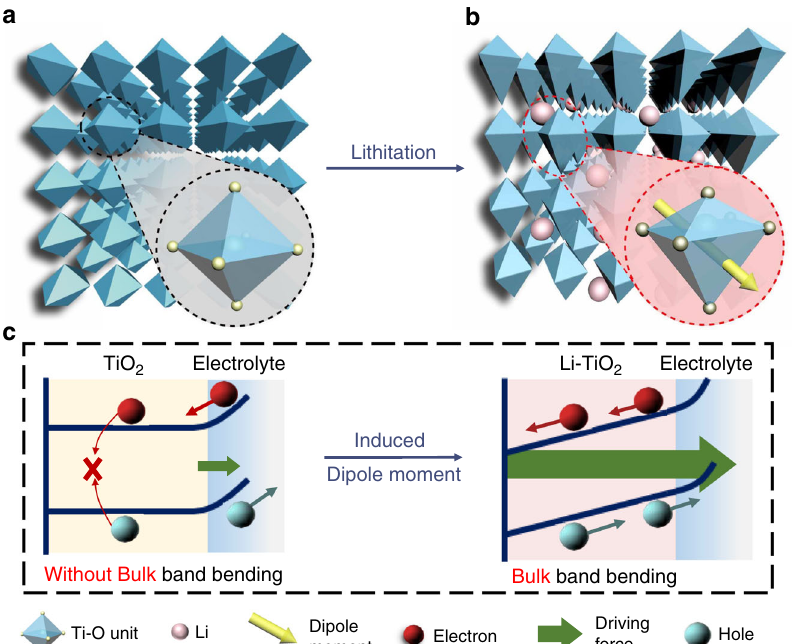
Fig. 1 Schematic changes of anatase TiO2 upon lithiation. The schematic bulk lattice structures of ( a , b ) pristine and lithiated TiO 2 . Insets in a and b are the typical TiO 6 unit cells without and with the distortion, which leads to asymmetric Ti-O bonds and generates a dipole moment as presented by the arrow in b . c Schematic of the band bending and driving force in the TiO 2 and Li-TiO 2 bulks without and with the lattice distortions induced dipole moments, respectively. The band bending and driving force exists only in surface layer of TiO 2 but in both surface layer and bulk of Li-TiO 2